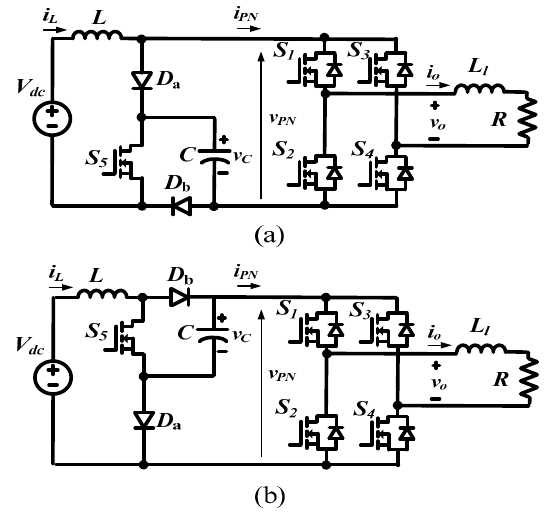
Figure 2. Single-phase qSBIs ( a ) type 1 and ( b ) type 2.